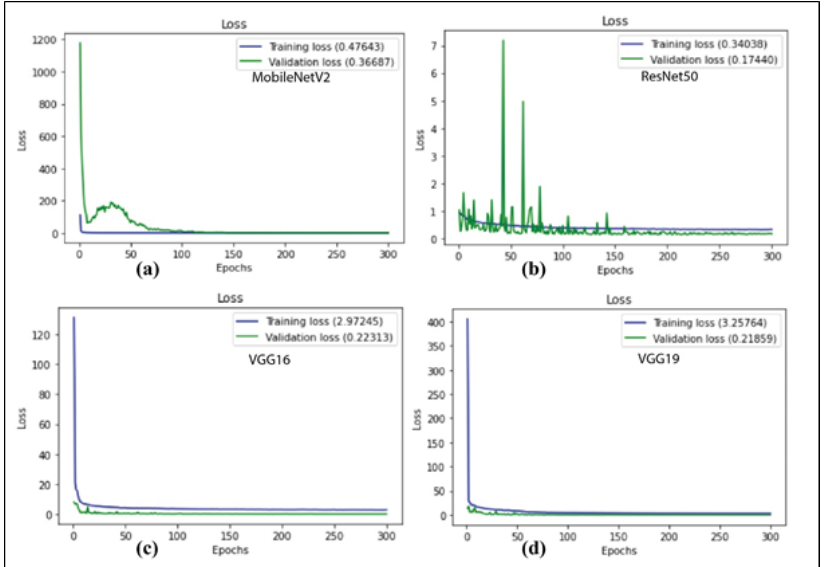
Figure 7. Model loss of iris key points detection over 300 epochs ( a ) MobileNetV2 ( b ) ResNet50 ( c ) VGG16 ( d )